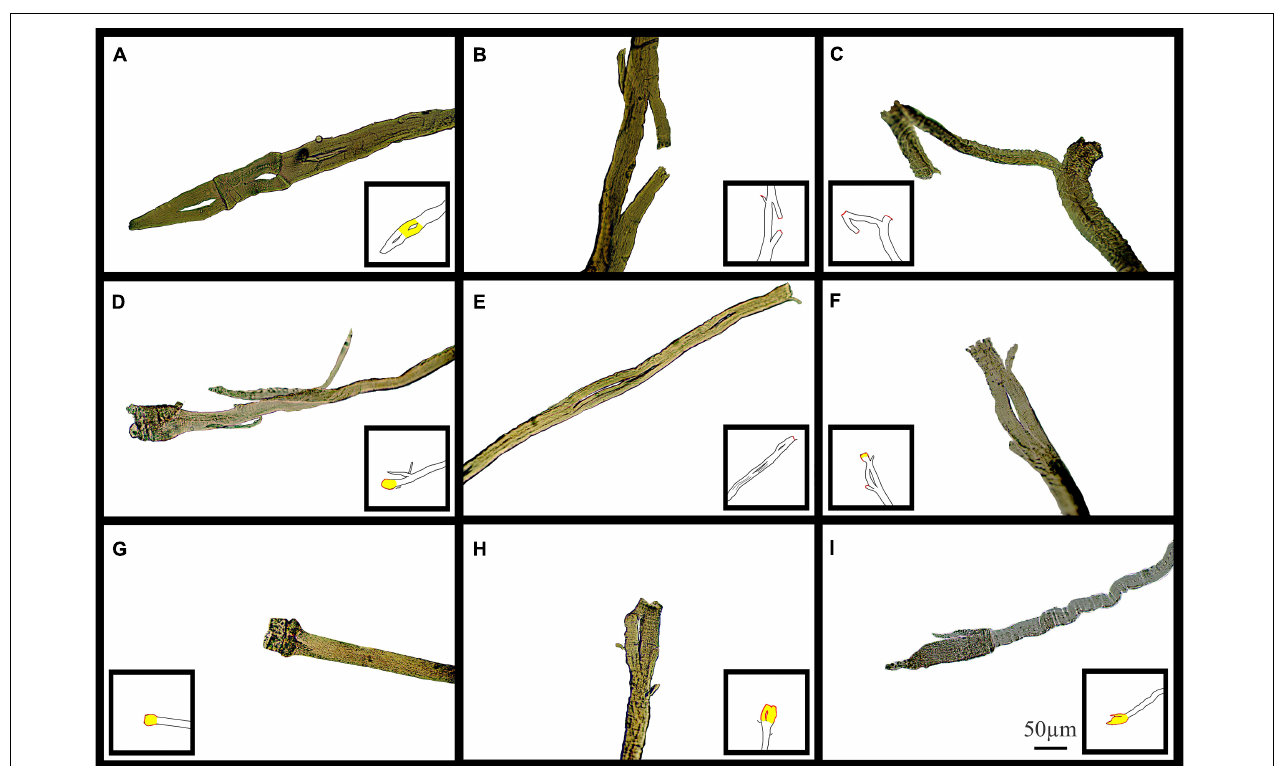
FIGURE 11 | Examples of medium power light microscope images (X100) of broken muscle fiber sections that have undergone ECs from adult and senescent mdx mice. Broken areas have been outlined in red whilst swollen and necrotic areas highlighted yellow in cartoon inserts for each image. (A–D) Are portions of fibers from a 22-month mdx mouse EDL. (E–I) Are portions of fibers from a, 18-month mdx mouse EDL. Scale bar provided at 50 µ m in (I) applies to all of